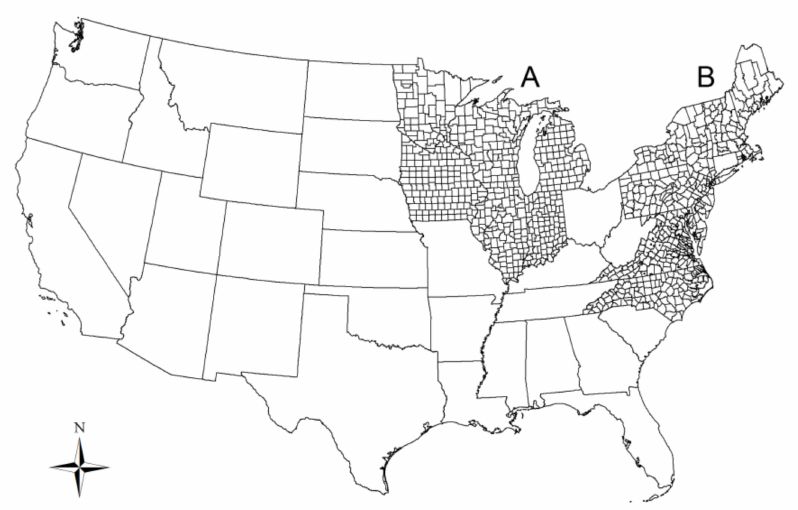
Figure 1. Map of study area. A—the Upper Midwest; B—the Northeast of United States.